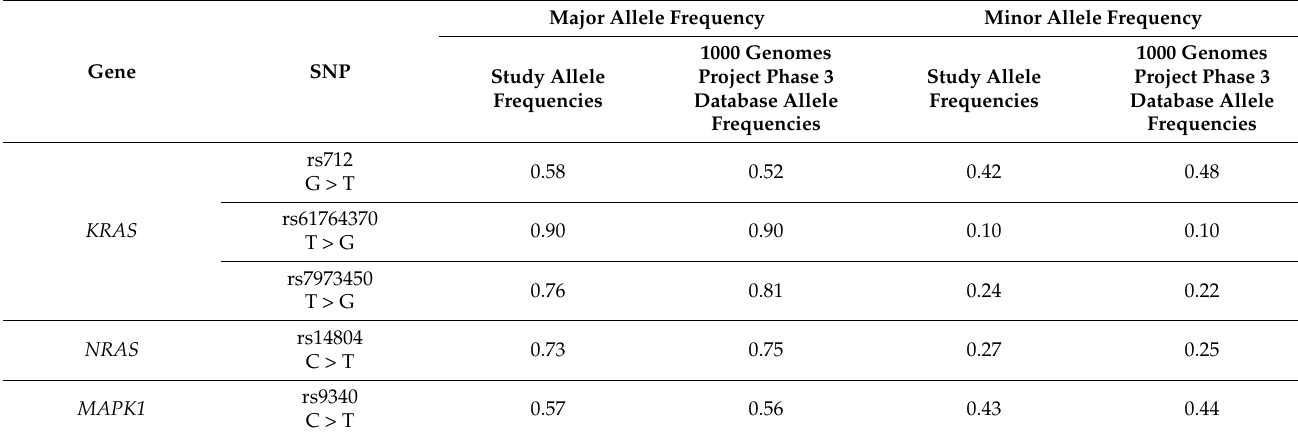
Table 3. Allele frequencies of analyzed single nucleotide polymorphisms in the study population and European population data from the 1000 Genomes Project Phase 3 database.